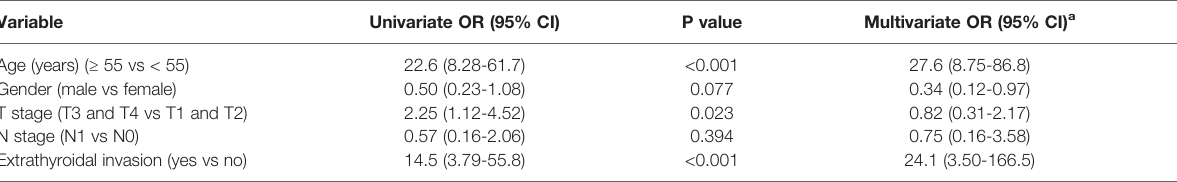
TABLE 2 | Risk factors associated with distant metastasis in 190 patients with follicular thyroid cancer.